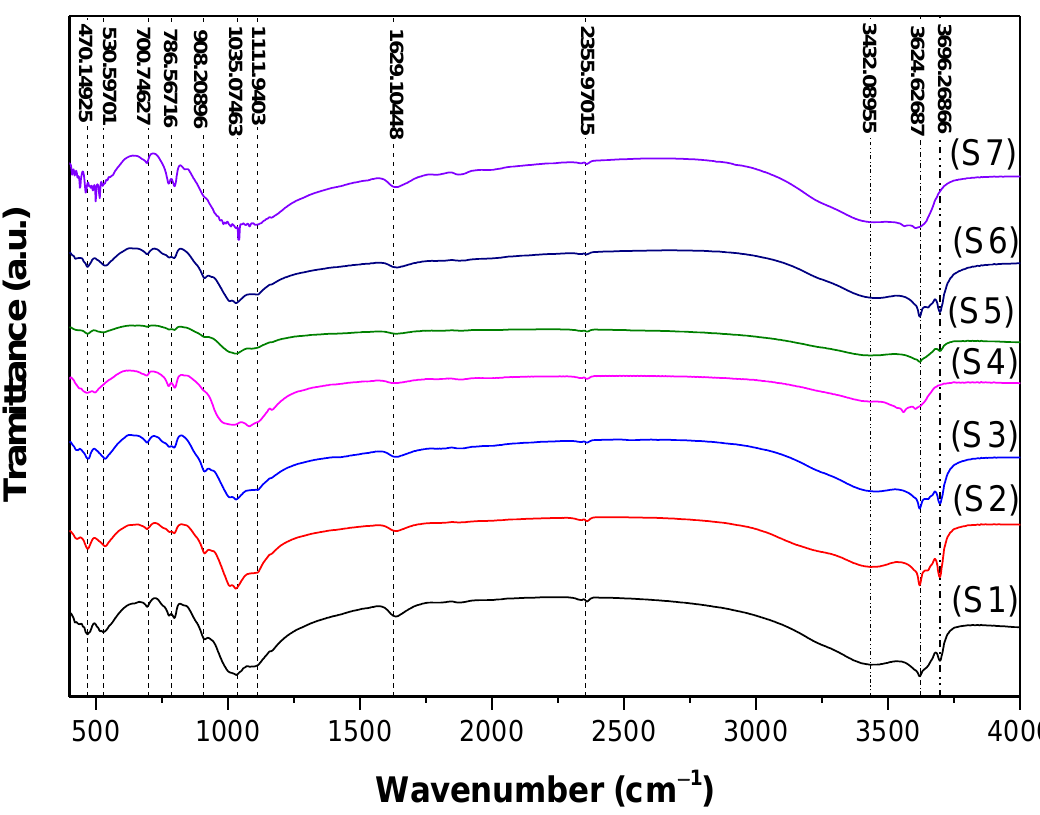
Figure 4. FTIR spectra of clay samples (S1, S2, S3, S4, S5, S6, and S7).